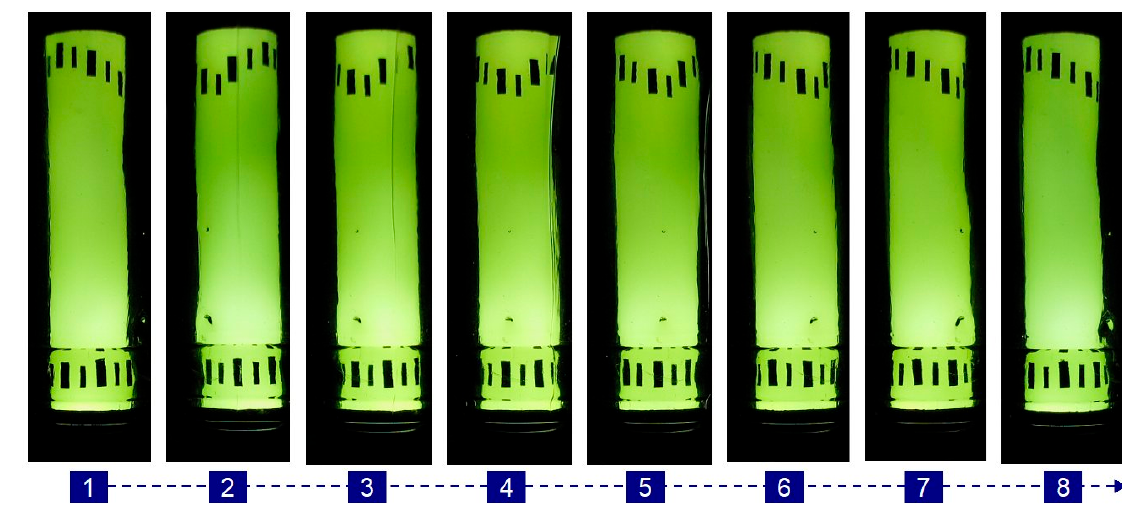
15 of 21 Figure 11. Average performance obtained in the indoor image set: ( a ) Influence of parameter i on performance as a func- tion of 𝜀 . ( b ) The effect of 𝜀 in the method performance as a function of parameter i . 4.3. Industrial Image Set The third and last set includes 120 sequences of faulty bottlenecks images with low